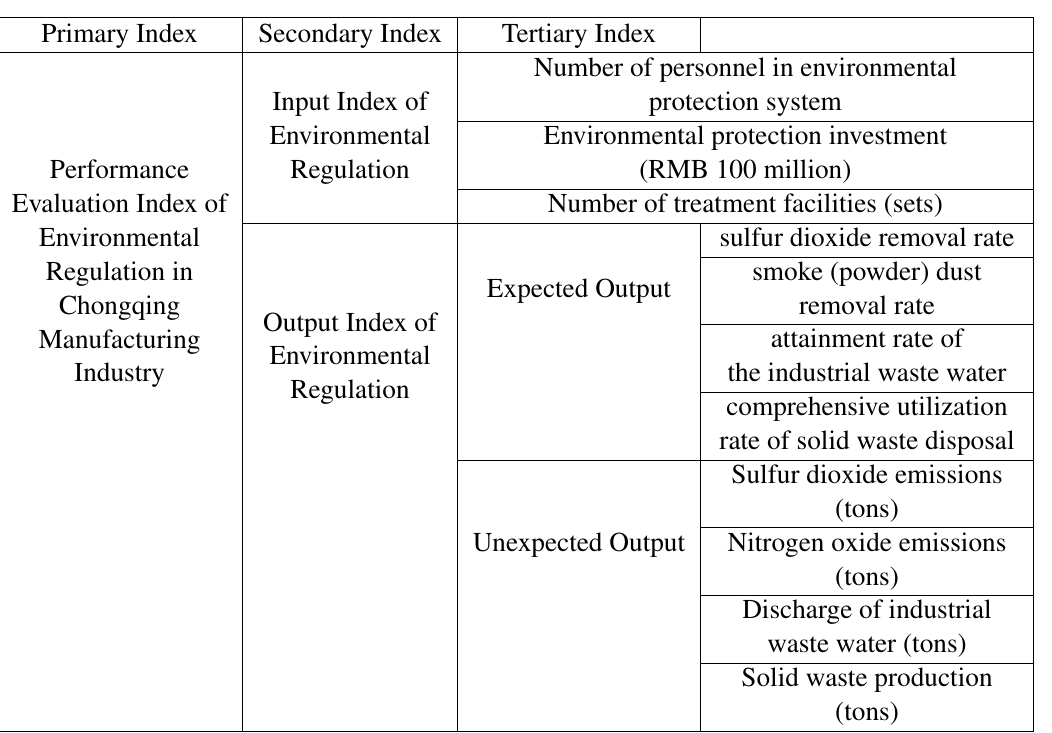
Table 1 Evaluation index system of environmental regulation performance of